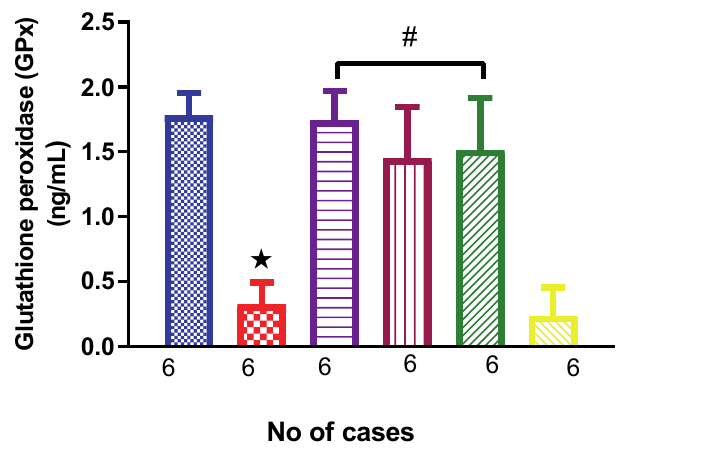
Figure 5. Shows GPx activity in normal control (NC), prediabetic control (PD), metformin and diet intervention (MET + DI), metformin and high-fat/high-carbohydrate diet (MET + HFHC), rhenium (V) compound and diet intervention (Re + DI), and rhenium (V) compound and high-fat/high-carbohydrate diet (Re + HFHC) groups after 12 weeks of treatment. Values are presented as means ± SEM (n = 6). (cid:70) p < 0.05 in comparison with NC; # p < 0.05 in comparison with PD, MET +DI, MET + HFHC, Re + DI and Re +